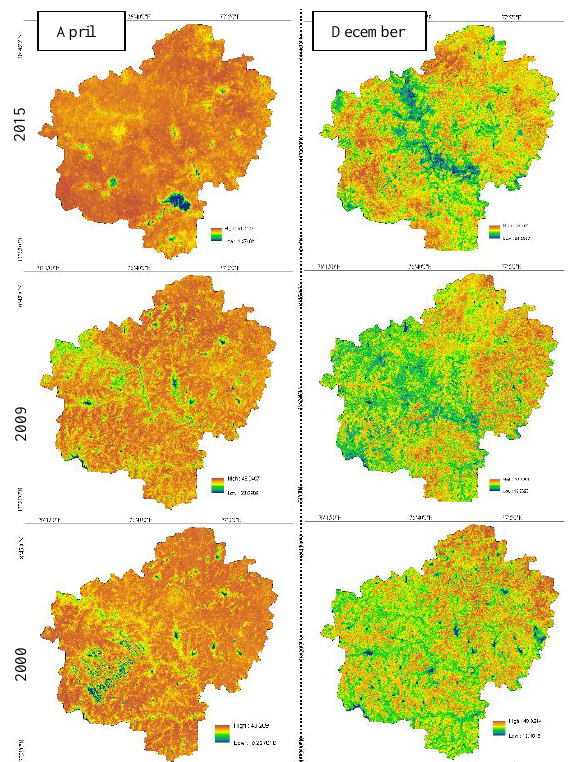
Figure 7: Spatial variation of LST for April and December